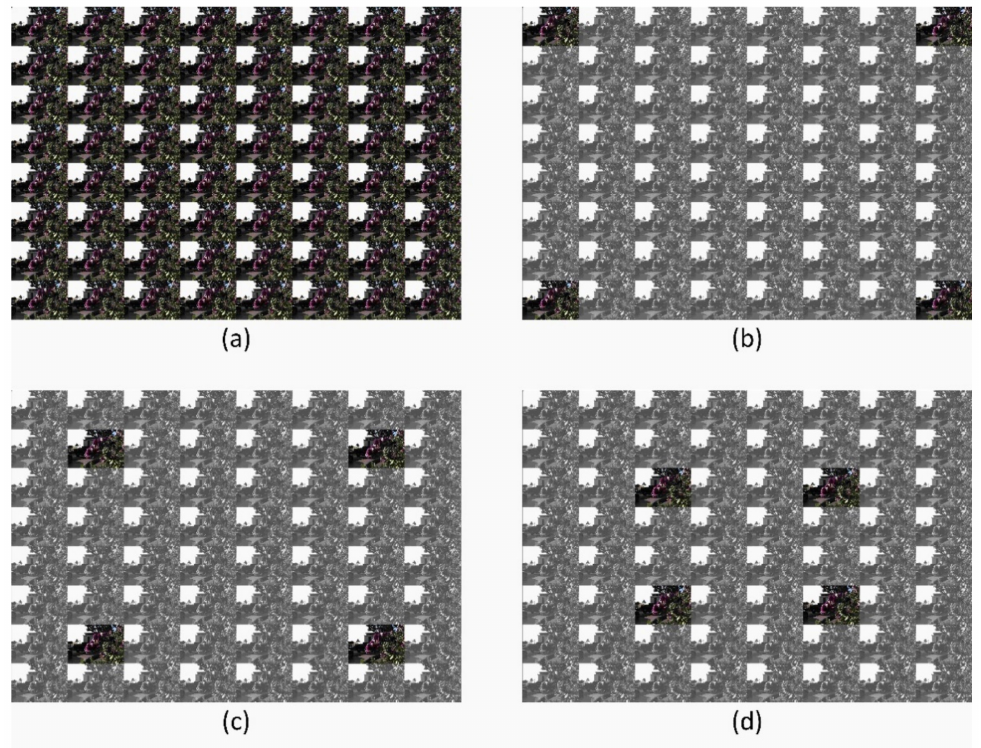
Figure 1. LF input–output relationship for different reconstruction tasks; 8 × 8 views are reconstructed from 2 × 2 views to generate 60 novel views. Colored images represent ground-truth and input views, while gray images represent output views to be reconstructed; ( a ) 8 × 8 ground-truth views are used to train the network for different reconstruction tasks, ( b ) task 1: 2 × 2 − 8 × 8 extrapolation 0, ( c ) task 2: 2 × 2 − 8 × 8 extrapolation 1, ( d ) task 3: 2 × 2 − 8 × 8 extrapolation